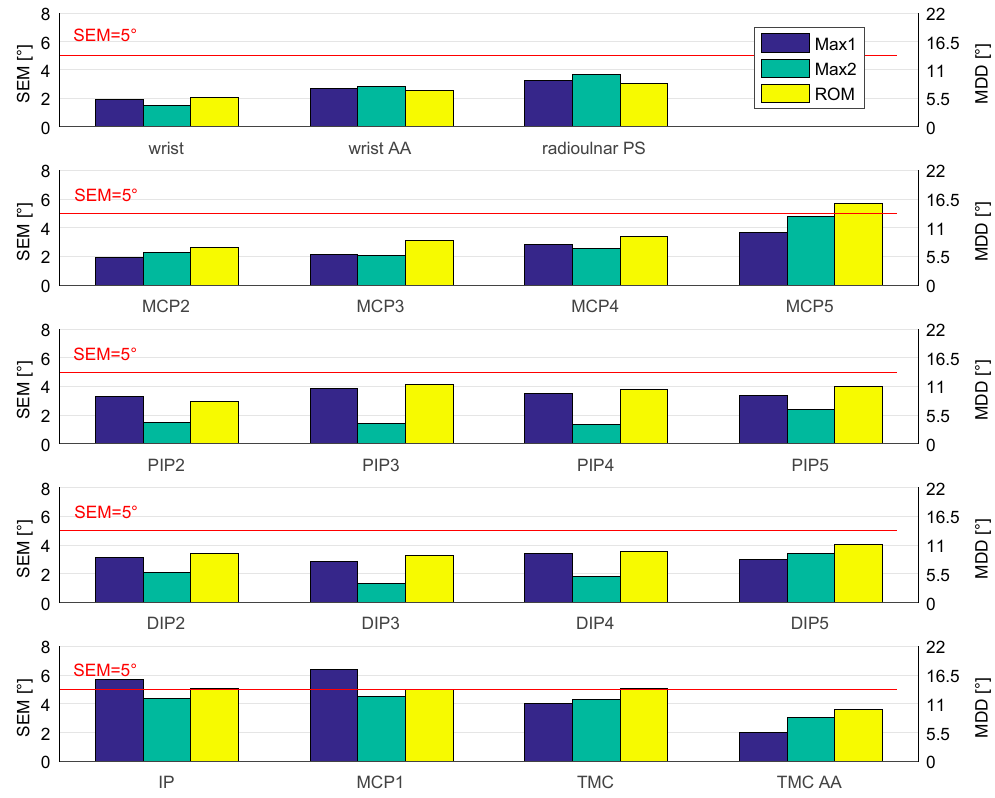
Figure 5. SEM (left scale) and the MDD (right scale) for the maximal angles and ROM. AA = adduction (Max1)-abduction (Max2); PS = pronation (Max1)-supination (Max2); all other: flexion (Max1)-extension (Max2). Data sets included n = 20; exceptions for MCP1: n = 19, MCP4: n = 19, MCP5: n = 18, DIP5: n = 19, TMC: n = 19, and radioulnar PS: n = 16.